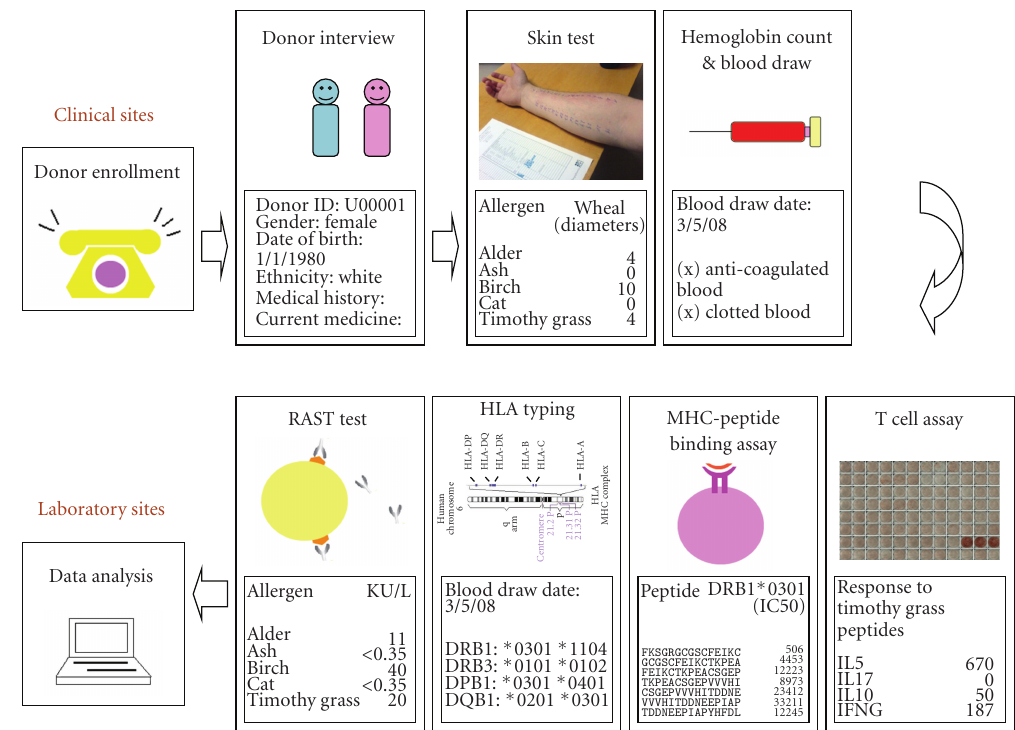
Figure 1: The allergy epitope mapping research workflow. In this study, allergic and normal donors were enrolled at two clinical sites (University of California, San Diego and National Jewish Medical Research Center). During the clinical interview, donor demographic information and medical history were recorded. Following that, allergen skin tests, hemoglobin test, and blood sample collection were performed. All the data and blood samples were sent to LIAI for further experiments and analyses. At LIAI, blood samples were tested for their immunogenicity (T cell activities) against a selected panel of peptides derived from common human allergens by ELISPOT assays [20] (T cell assays). Concurrently, the selected peptides were tested for their binding capacities to a set of common MHC molecules [21]. Peptide binding to MHC molecules is a necessary, but not su ffi cient, requirement for T cell recognitions [22]. Blood samples were also sent to an external company for radioallergosorbent (RAST) and human leukocyte antigens (HLA) typing test. The RAST test detects the amount of the IgE antibody in the blood that reacts with a specific allergen [23]. HLA typing determines the specific HLA types expressed by the donor, which is an indication of MHC restriction [24, 25]. The figure of skin test was adapted from the Wikimedia Commons file “File:Allergy skin testing.jpg”. The figure of HLA typing was adapted from the Wikimedia Commons file